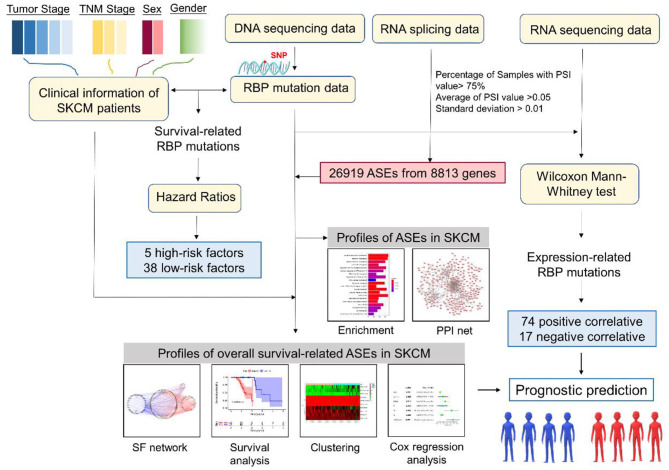
Flow diagram of the research methodology. RBP, RNA-binding protein; ASE, alternative splicing event; SF, splicing factor; PPI, protein–protein interaction.